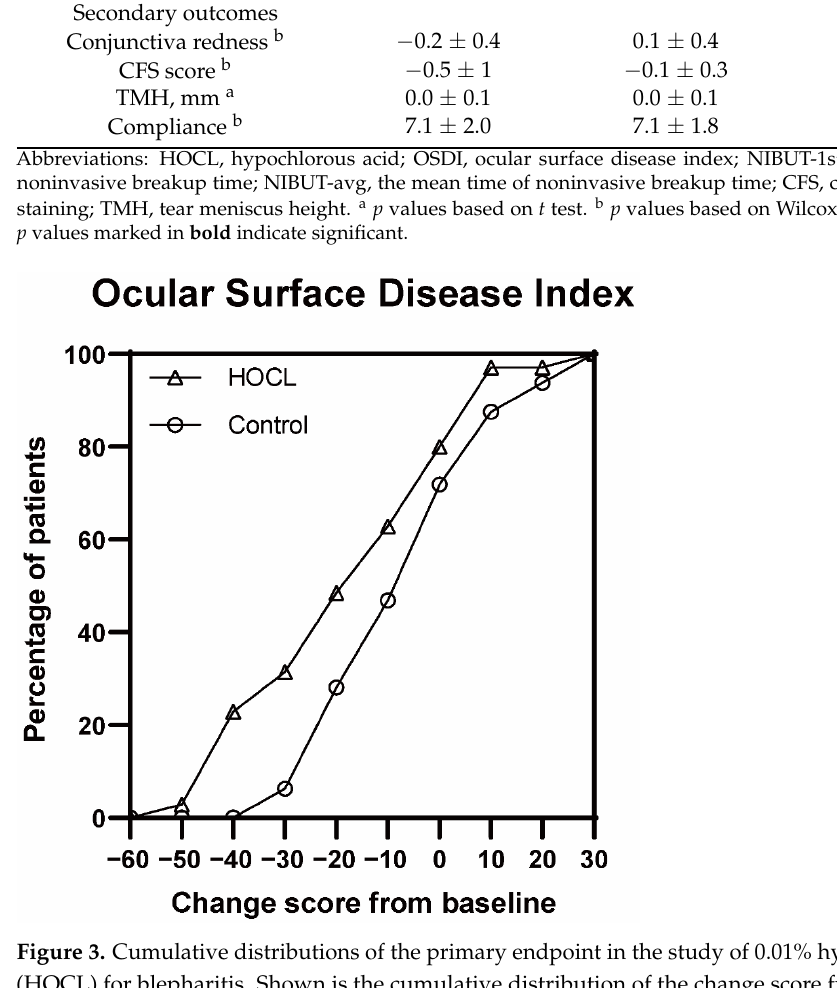
Figure 4. Representative images of lid margin findings and corneal fluorescein staining in hypochlorous acid group. Note that obvious lid margin redness and plugging of gland orifices are observed at baseline ( A ) and alleviation of these signs occurs after 2 weeks ( B ). There was a confluent